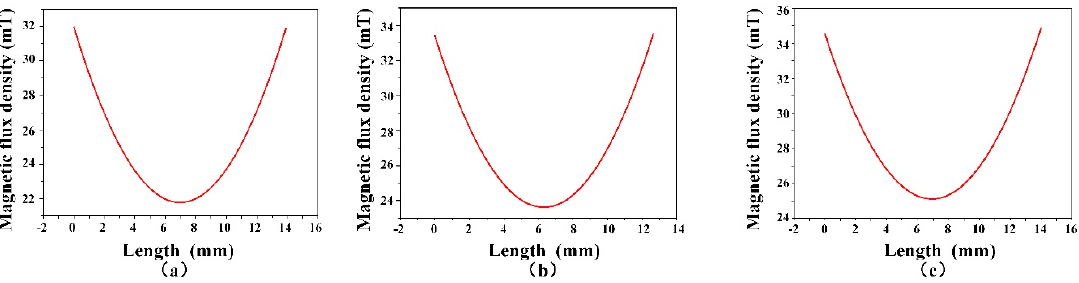
Figure 3. The magnetic flux density range at the position of magnetostrictive material. ( a ) Sensor based on the cuboid magnetostrictive material. ( b ) Sensor based on the cylindrical magnetostrictive material. ( c ) Sensor based on the semi-cylindrical magnetostrictive material. Table 1. Summary of sensors with different structures.